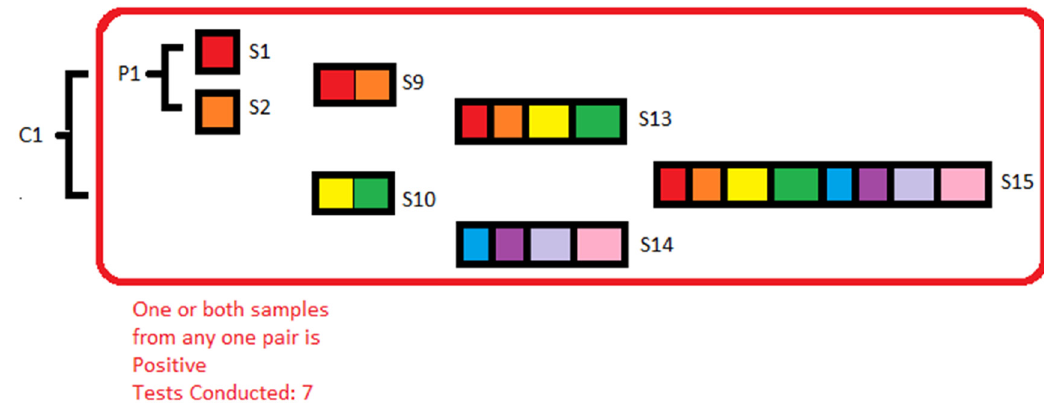
Figure 4: Seven tests to be performed for testing eight individuals.